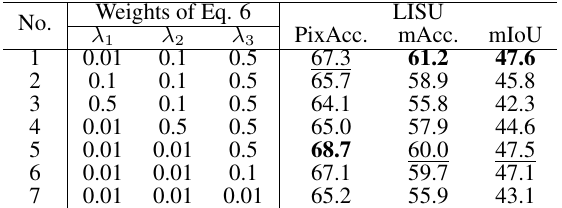
Table 4. Study of the influence of weights of Eq. 6 on segmentation. The best and the second best results are highlighted in bold and underlined.